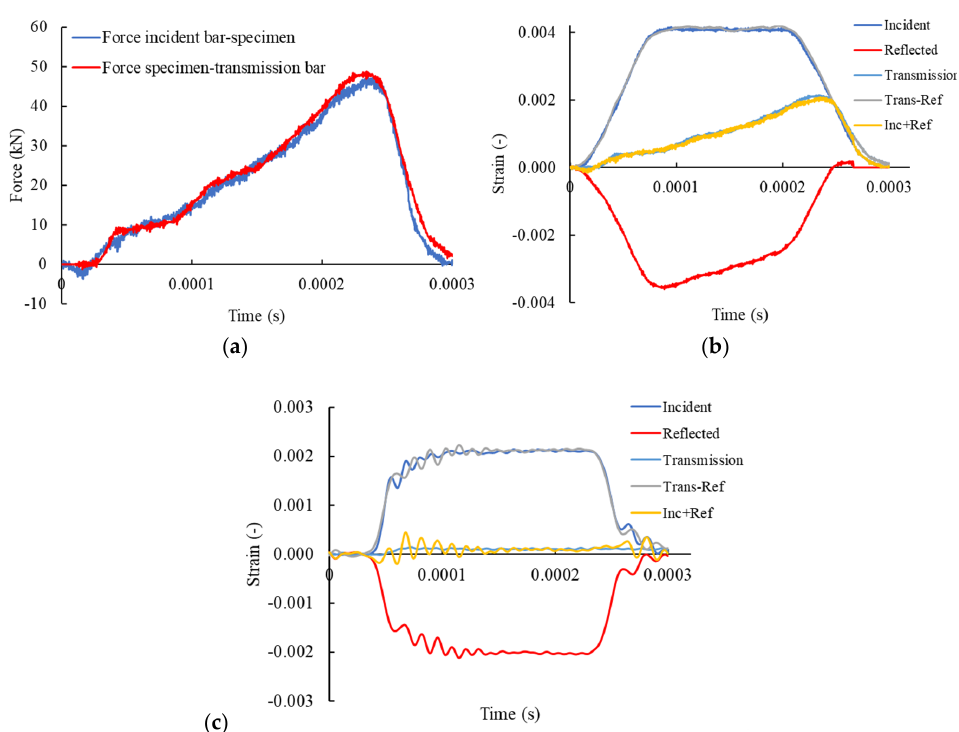
Figure 2. An example of ( a ) dynamic force equilibration, ( b ) strain equilibration with pulse shaper, and ( c ) strain equilibrium without pulse shaper.